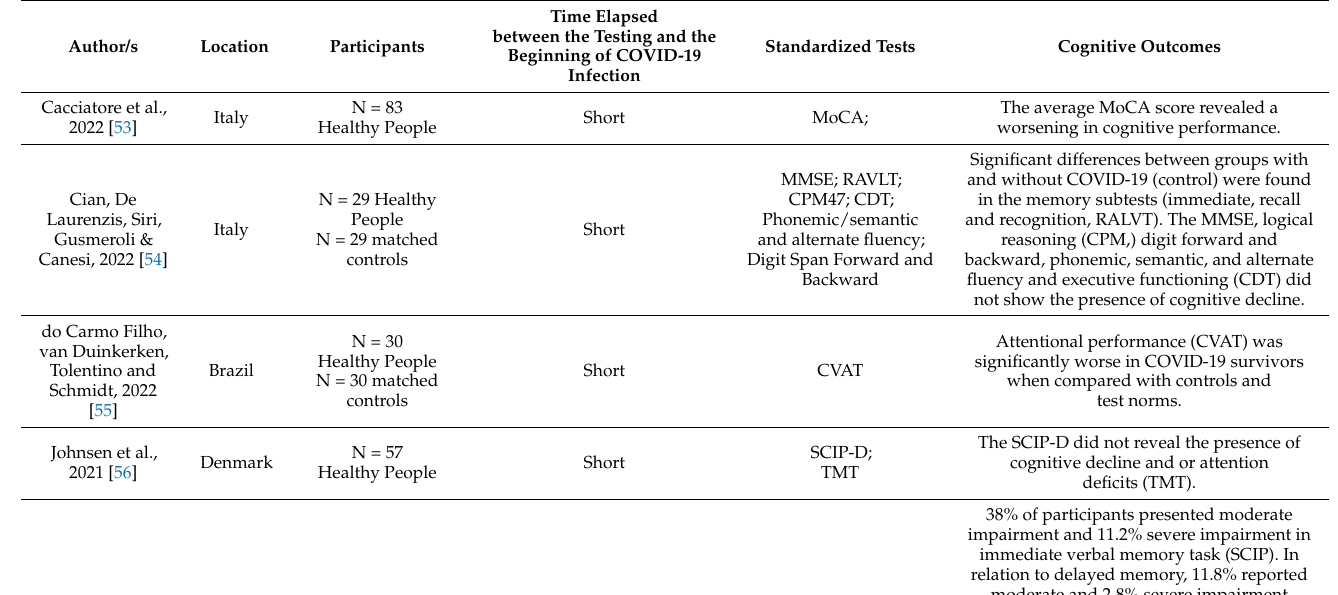
Table 2. Summary of studies reporting the negative effects of COVID-19 infection on cognitive performance in healthy people for the three time periods (short 1–4 months, medium 5–8 months, long 9–12